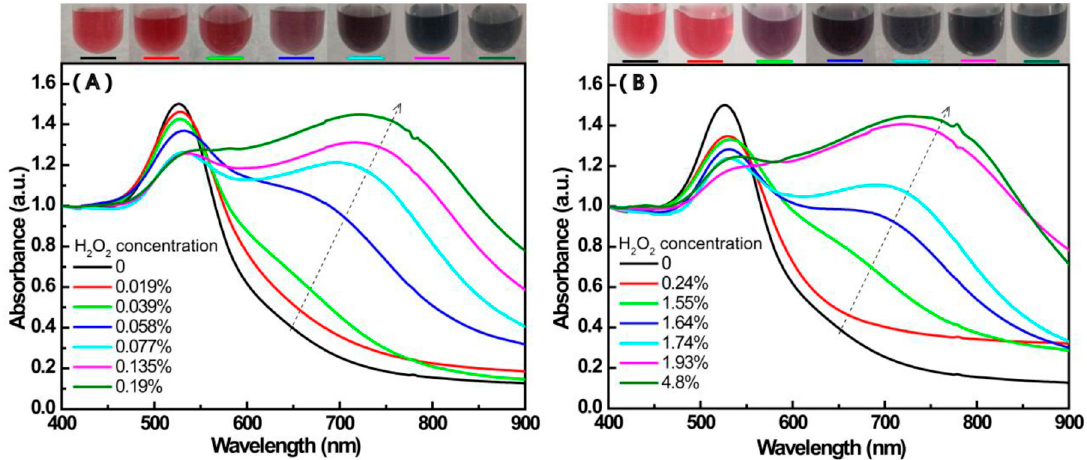
Figure 3. The UV-Vis spectrum of Mixt.1 ( A ) (0.16 mM 4-MPBA) and Mixt.2 ( B ) (1.28 mM) in the presence of different concentrations of H 2 O 2 with photographs of their corresponding samples.